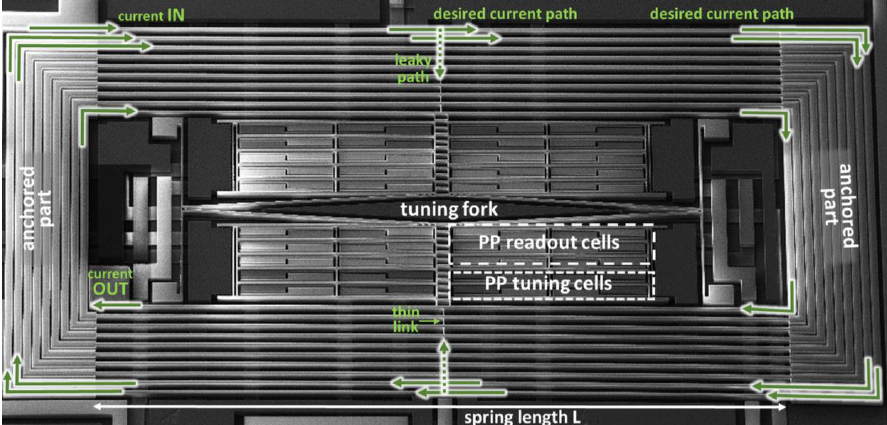
Figure 28. SEM image of diamond-shaped tuning fork, including 10 metal coils deposited over the springs and parallel plate (PP) cells. These cells are employed for capacitive readout and tuning [47]. Reprinted with permission from [47]. Copyright@2015, IEEE.